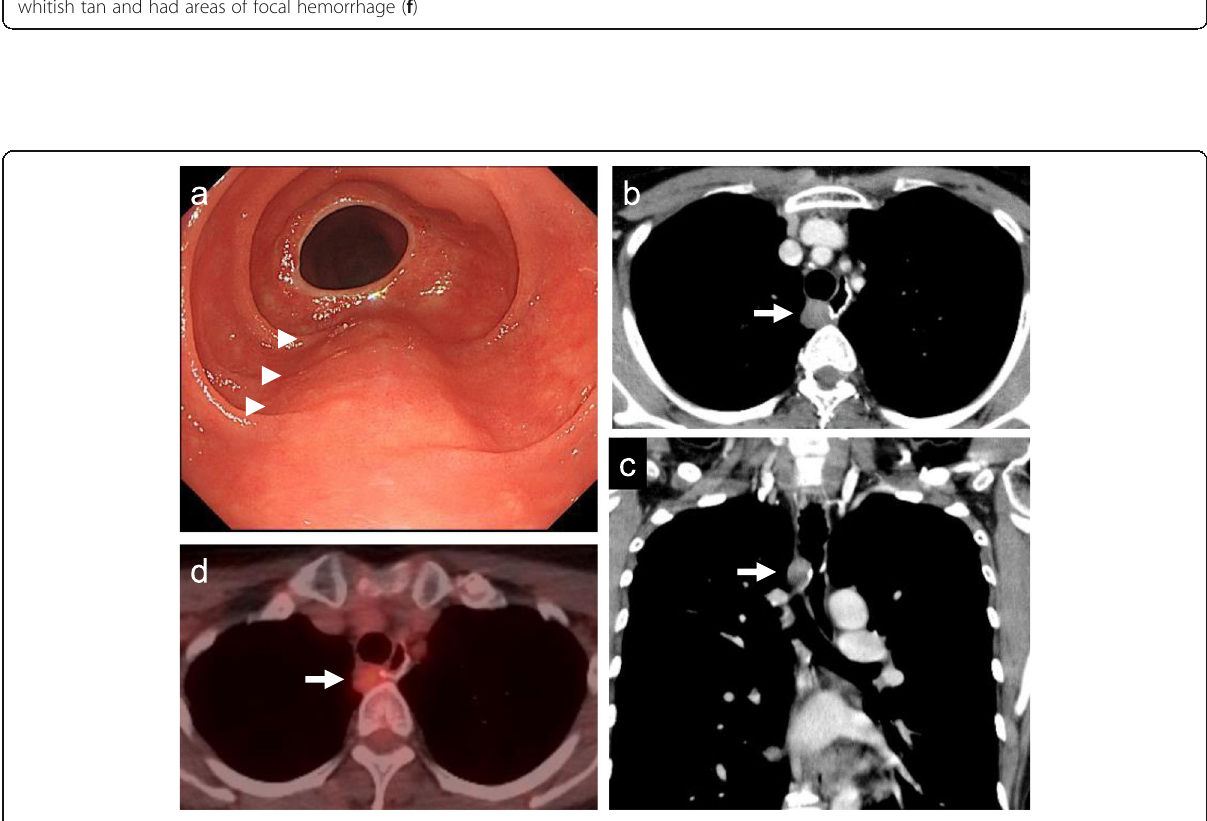
Fig. 3 Images obtained before the third operation. Esophagoscopy showed a 20-mm-sized extrinsic mass located at the distal anastomotic site between the jejunum and the esophagus (arrowheads) ( a ). Contrast-enhanced CT showed a globular mass at the distal anastomotic site between the jejunum and the esophagus (arrow) ( b , c ). FDG-PET/CT revealed some FDG uptake in the tumor (arrow) ( d